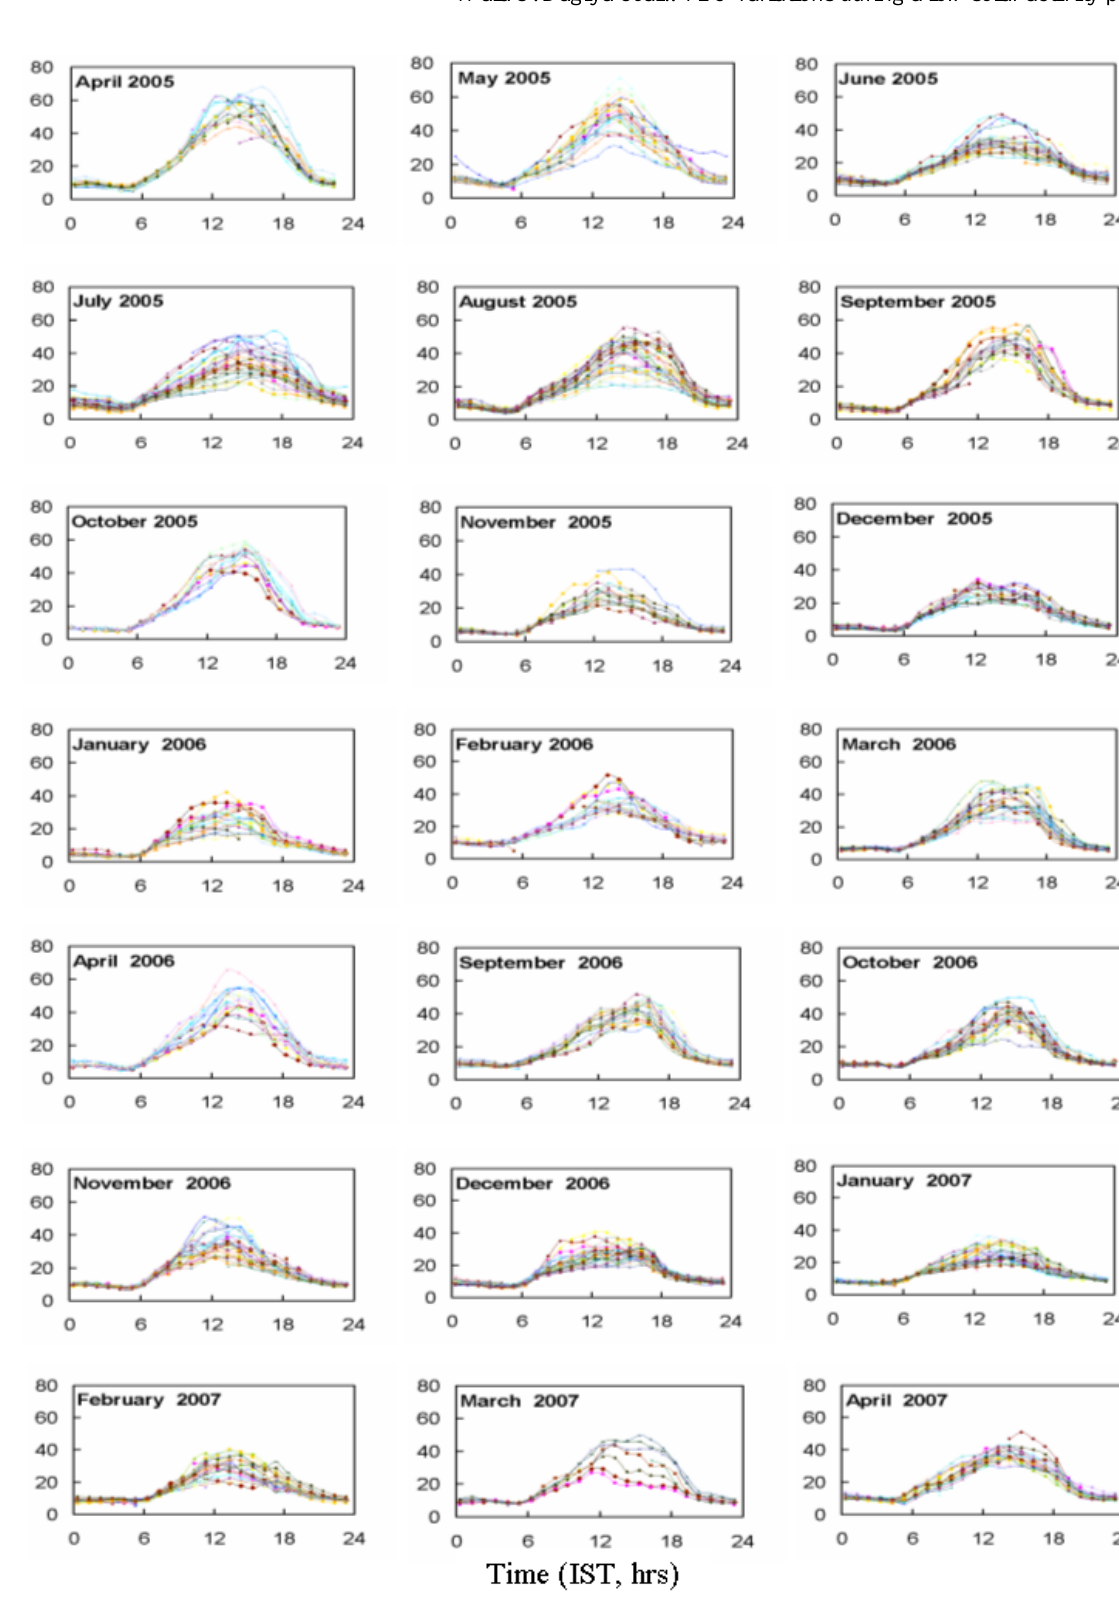
Fig. 2. Mass plot of Diurnal variation of Total Electron Content at Rajkot from April 2005 to April 2007 with the exception of May to August 2006 due to instrument